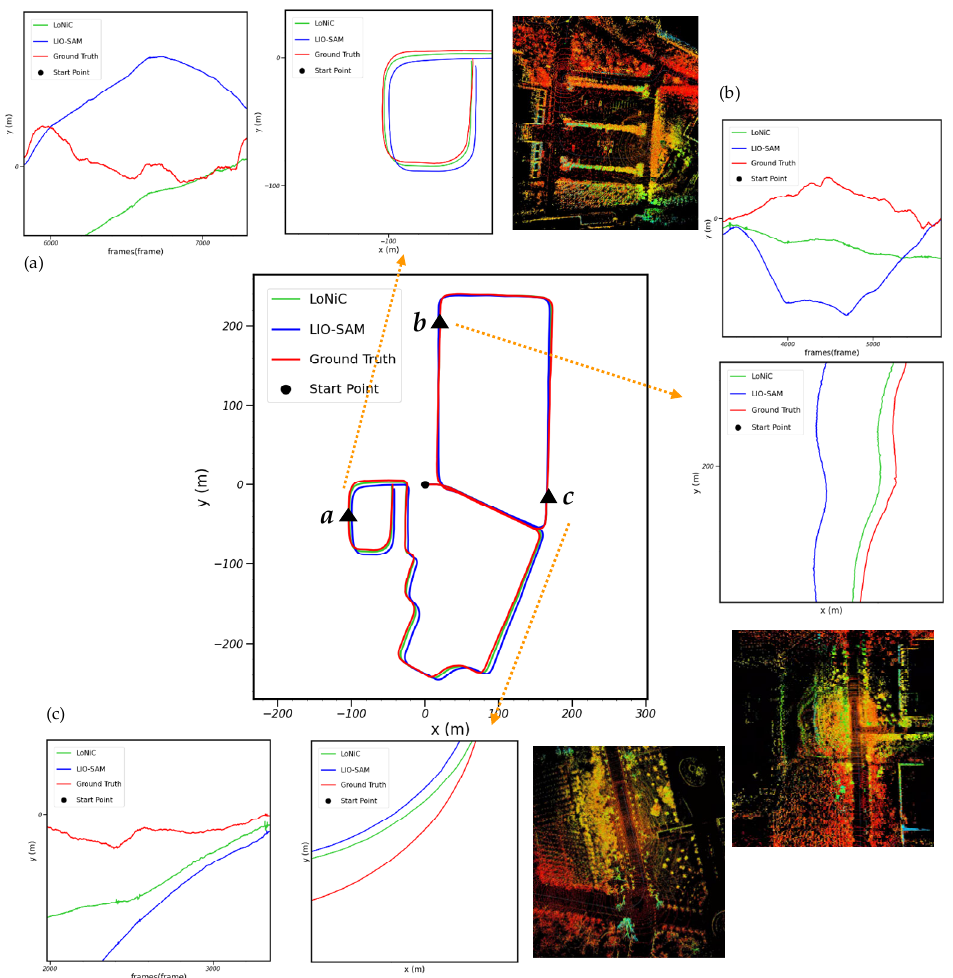
Figure 15. Trajectory map of sequence JLU_070101 on the JLU campus dataset: a, b and c refer to the comparison of elevation fluctuation trend, mapping trajectory, and mapping effect of road sections at the marked positions of ( a – c ), respectively.